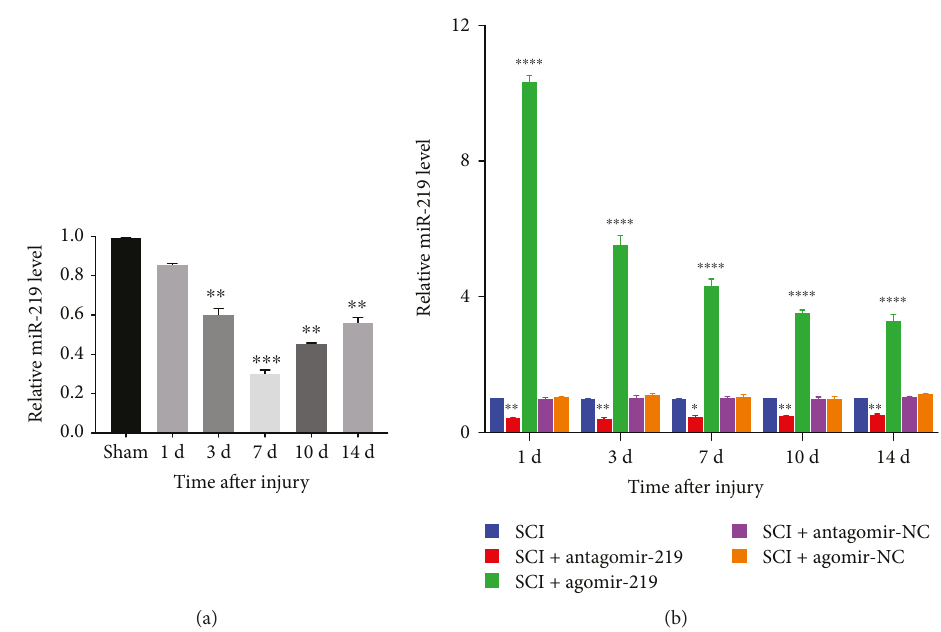
Figure 1: Expression of miR-219 in di ff erent groups. (a, b) Relative expression level of miR-219 detected by qRT-PCR over the time course in all groups. Each bar represent the means ± SEM for triplicate experiments. ∗ p < 0 05 , ∗∗ p < 0 01 , ∗∗∗ p < 0 001 , and ∗∗∗∗ p < 0 0001 . NC: negative